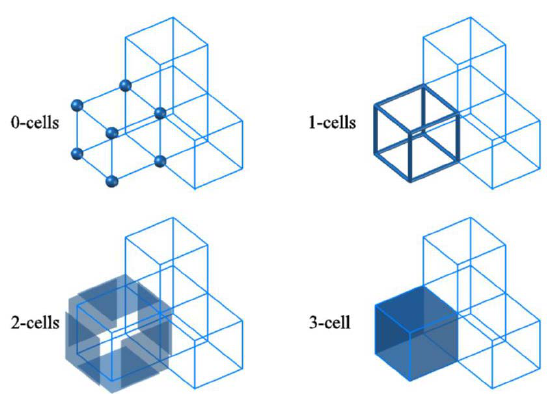
Figure 32: The four space elements in algebraic topology.